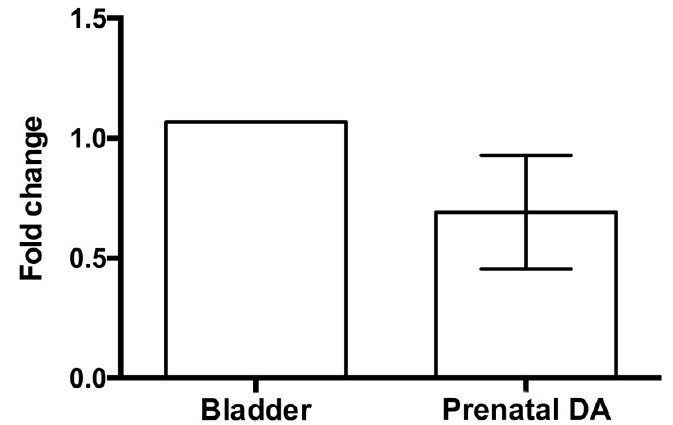
Figure 2. Expression of β 3-AR mRNA on ductus arteriosus (DA) of 18.5 mouse fetuses. The results are represented as fold change in DA versus bladder, assumed as positive control. Data are the mean ± SEM of 5 independent experiments, each conducted in triplicate.